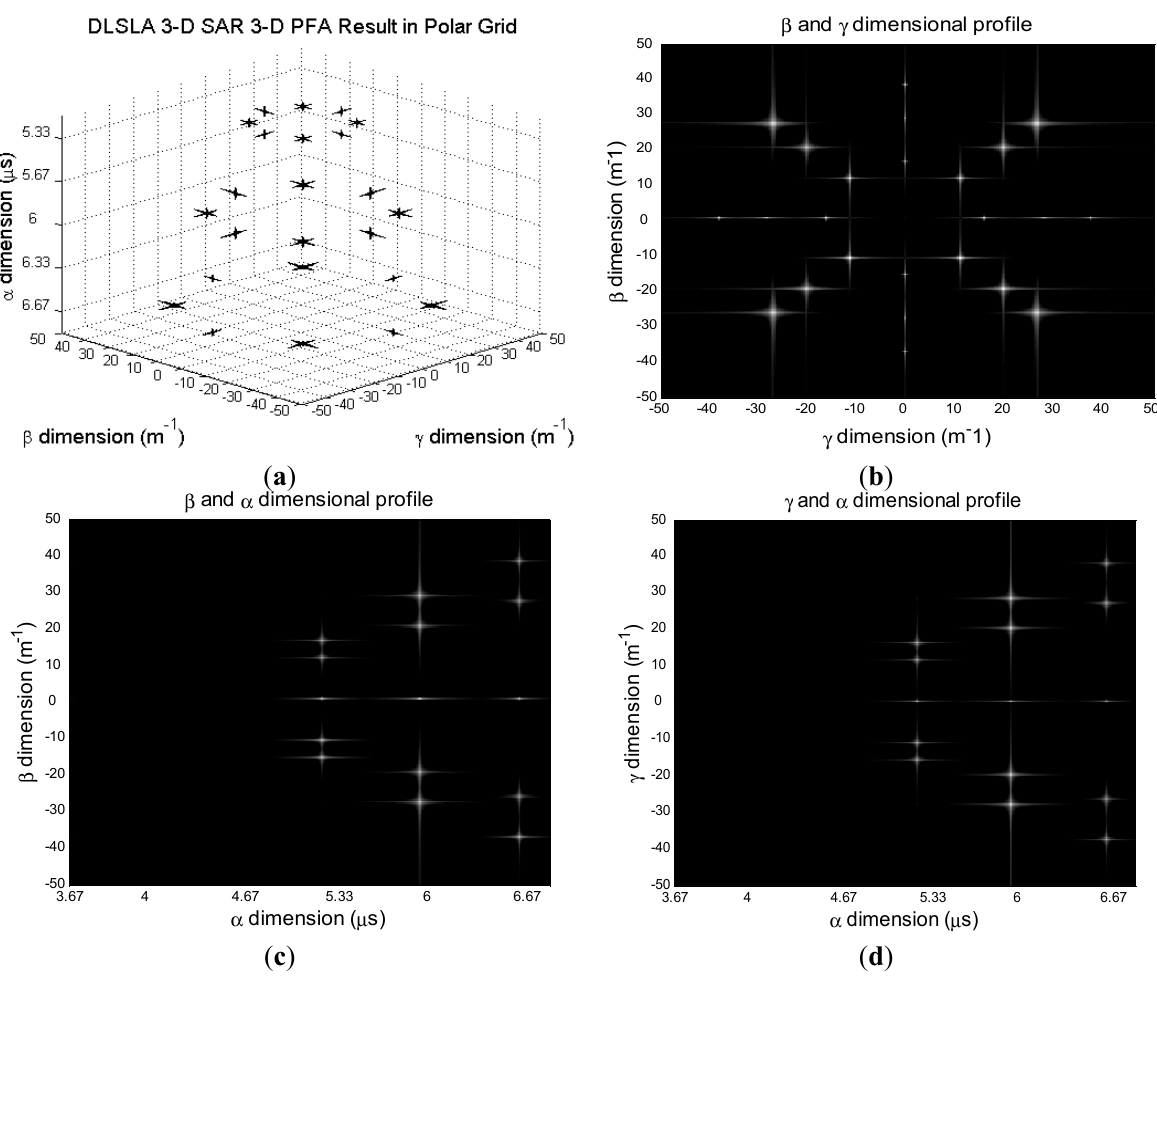
Figure 12. Imaging result in polar coordinate grid with wave front curvature error compensation: ( a ) 3-D imaging result. ( b ) Image projected onto βγ plane. ( c ) Image projected onto βα plane. ( d ) Image projected onto γα